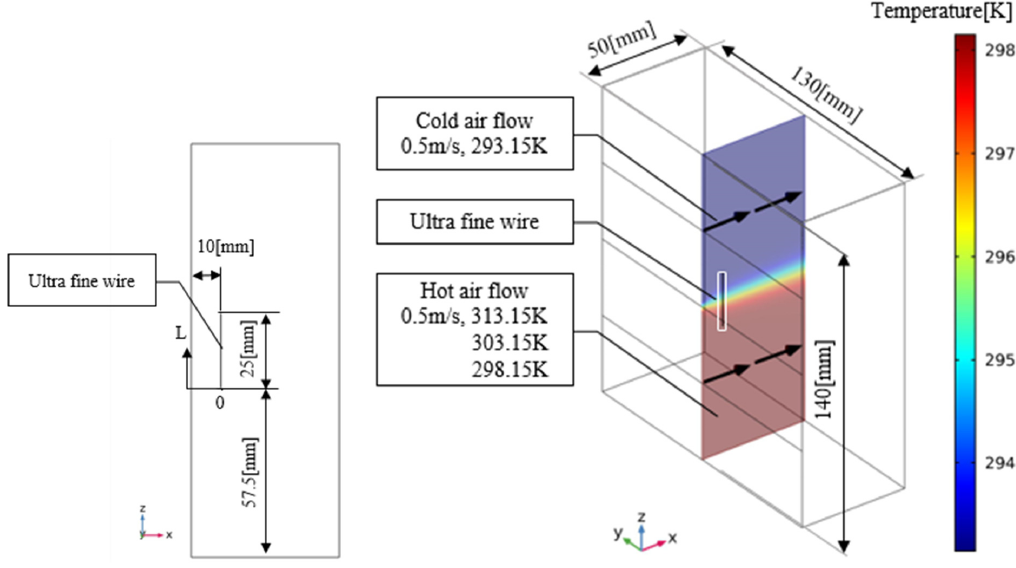
Figure 6. Analysis area and conditions of numerical simulation.